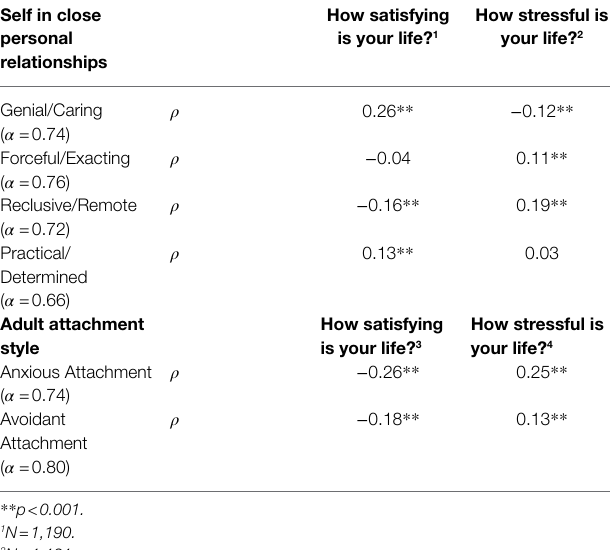
TABLE 7 | Trainees’ current life quality by personal self and attachment style.